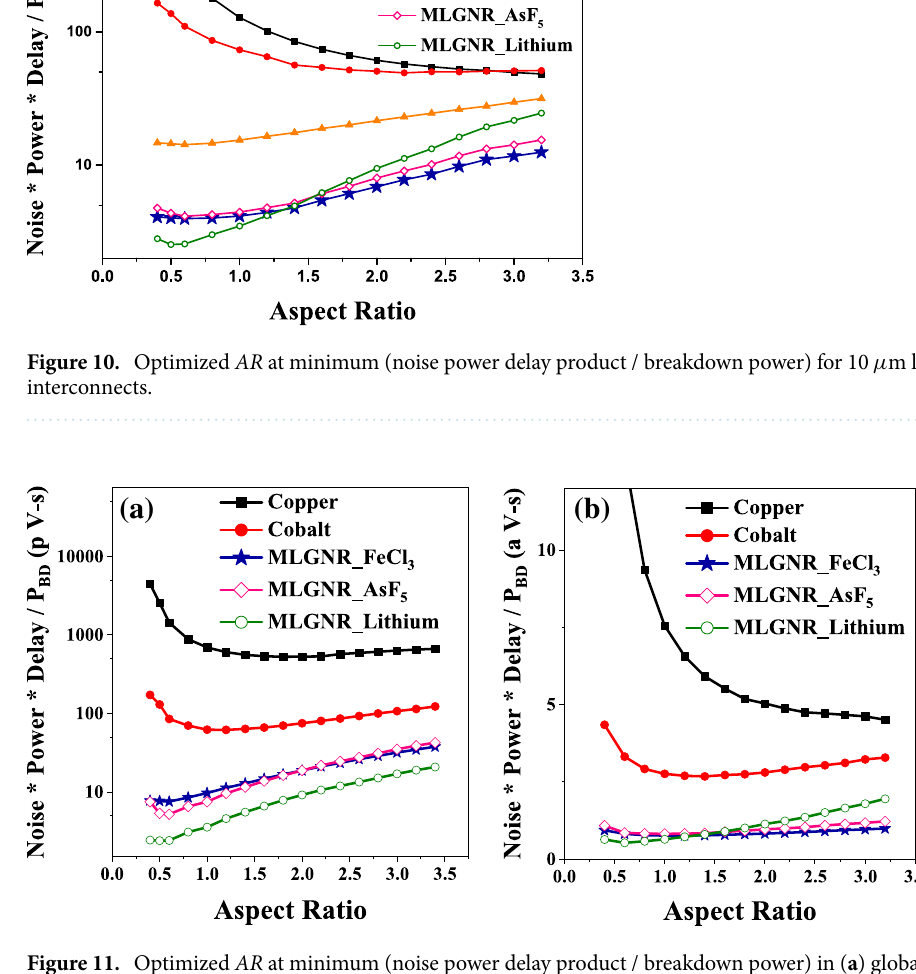
Figure 11. Optimized AR at minimum (noise power delay product / breakdown power) in ( a ) global level (L = 1 mm) and ( b ) local level (L = 500 nm) interconnects.